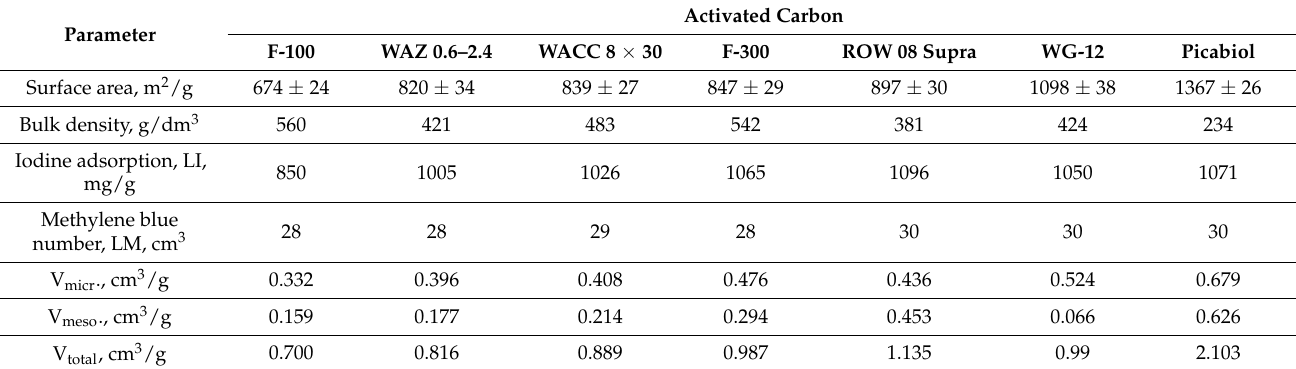
Table 5. Physical and chemical properties of activated